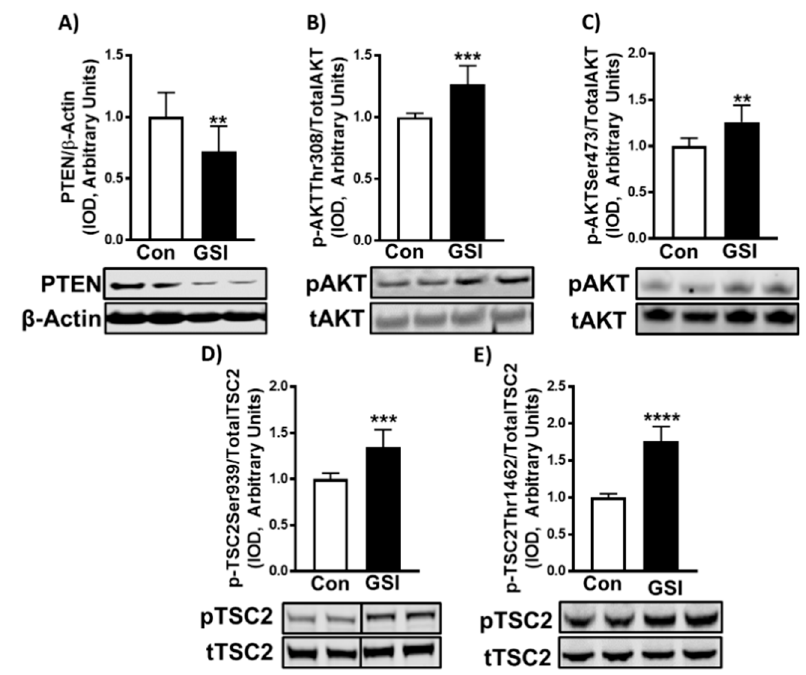
Figure 4. GSI increases signaling upstream of mTOR in C2C12 myotubes. ( A ) PTEN / β -Actin; ( B ) p-AKT Thr308 / Total AKT; ( C ) p-AKT Ser473 / Total AKT; ( D ) p-TSC2 Ser939 / Total TSC2; ( E ) p-TSC2 Thr1462 / Total TSC2 expression (Integrated optical density, IOD) in 96-h myoblasts treated with or without 4 µ m γ -secretase inhibitor (GSI) every 12 h. Thirty minutes prior to collection all cells were treated with 1 µ m puromycin. For representative image: lanes 1 and 2 are Con; lanes 3 and 4 are GSI. Data were analyzed using a Student’s T-test. ** p < 0.01 vs. Control (Con); *** p < 0.001 vs. Con; **** p < 0.0001 ( n = 3 experiments). Data are mean ± SD.